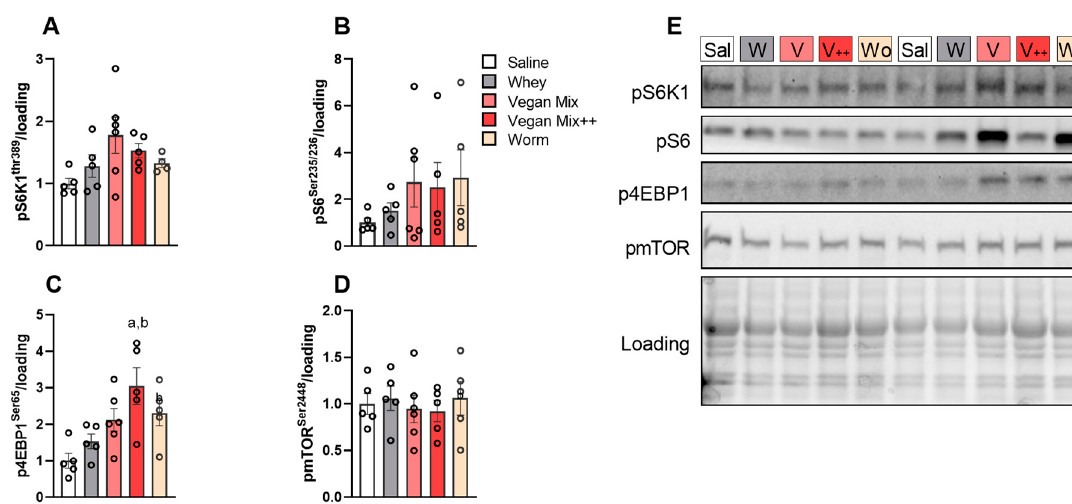
Figure 4. mTORC1 signalling 150 min in m. Tibialis Anterior after gavage of different AA mixtures. ( A ) pS6K1Thr389. ( B ) pRPS6Ser235/236. ( C ) p4EBP1Ser65 ( D ) pmTORSer2448. ( E ) Representative blots. Valine AUC. Data is presented as mean ± SEM, n = 5–6. Sal (Saline), W (Whey), V (Vegan Mix), V++ (Vegan Mix++), Wo (Worm). a p < 0.05 vs. saline, b p < 0.05 vs. whey.